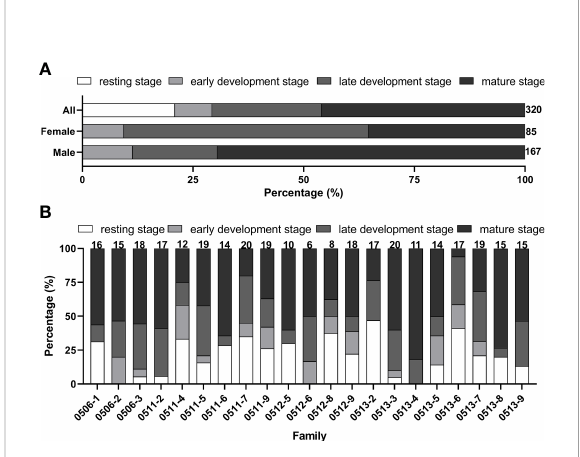
FIGURE 2 Distribution of gametogenic stages in different sexes (A) and families (B) of Crassostrea angulata at 4 months of age. Numbers above each column indicate sample